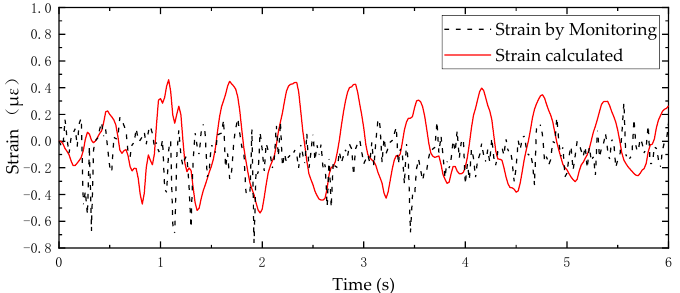
Figure 18. Comparison of dynamic strain between measurement and simulation results of DSS-10.